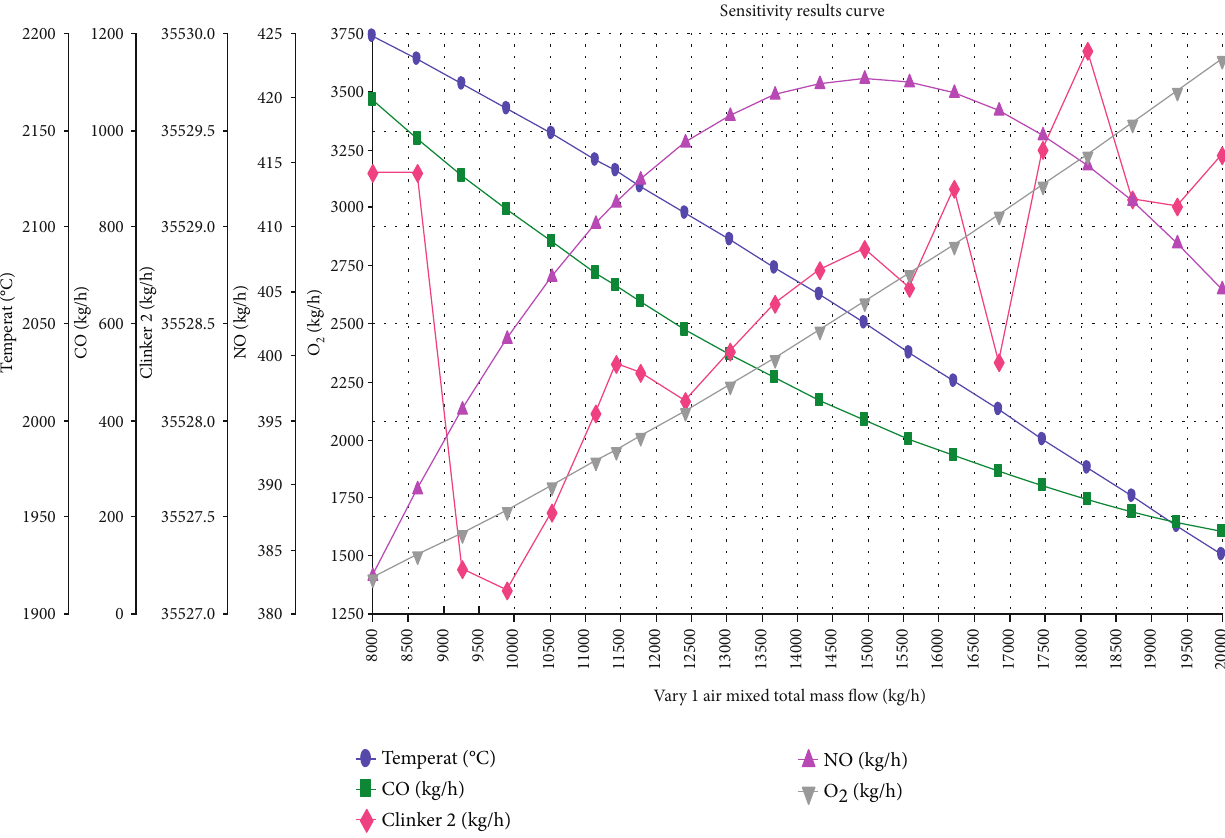
, NO, CO, and fl ame temperature (vertical 2